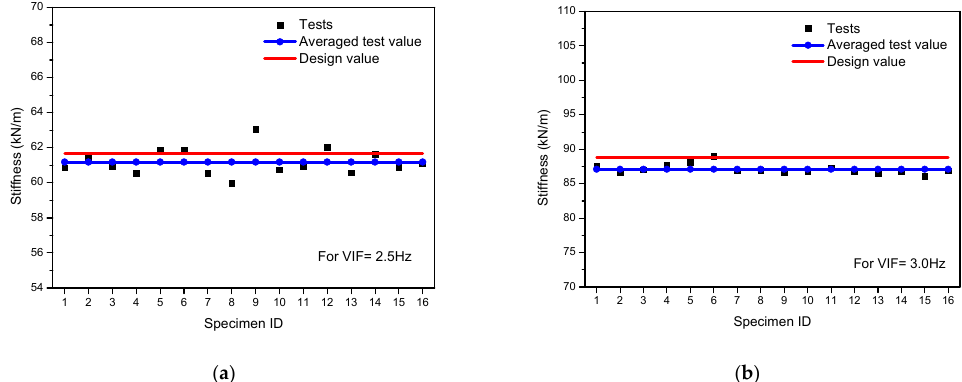
Figure 10. Comparison of stiffness between tests and design values of helical coil springs: ( a ) For VIF = 2.5 Hz; ( b ) for VIF = 3.0 Hz.